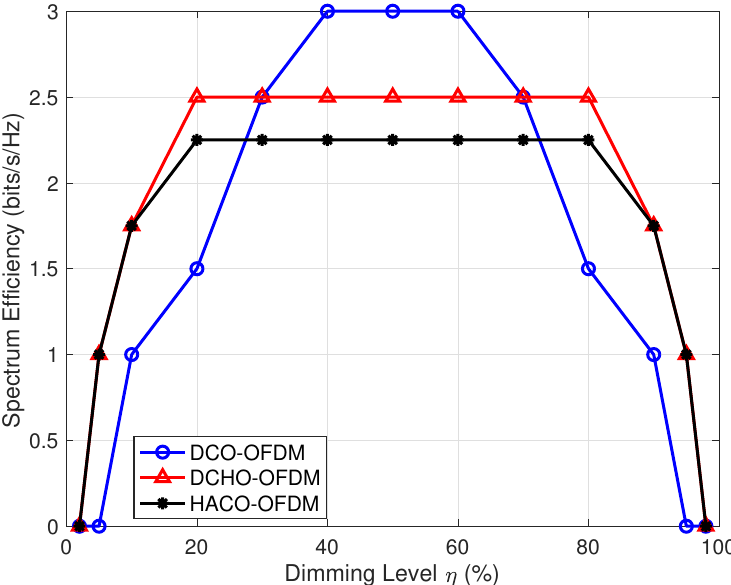
Figure 8. The achievable spectrum efficiency as a function of dimming level η , under a noise power of − 8